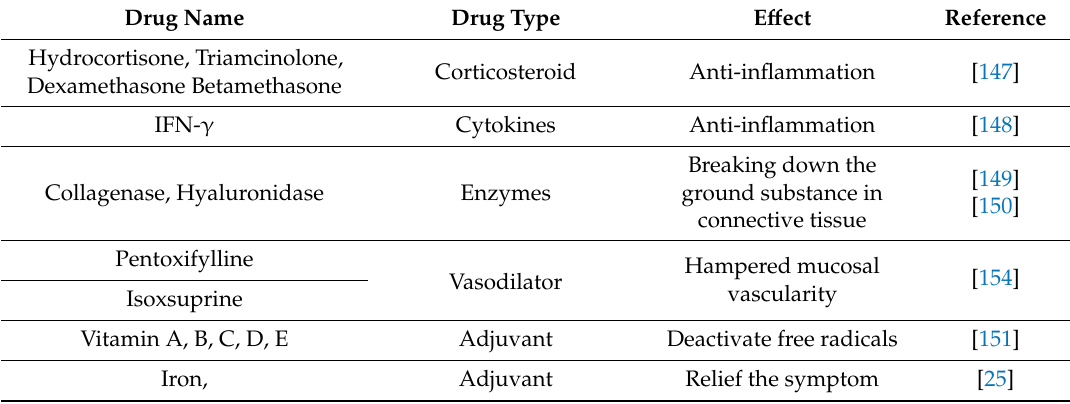
Table 5. The common drugs in clinical drug treatment of